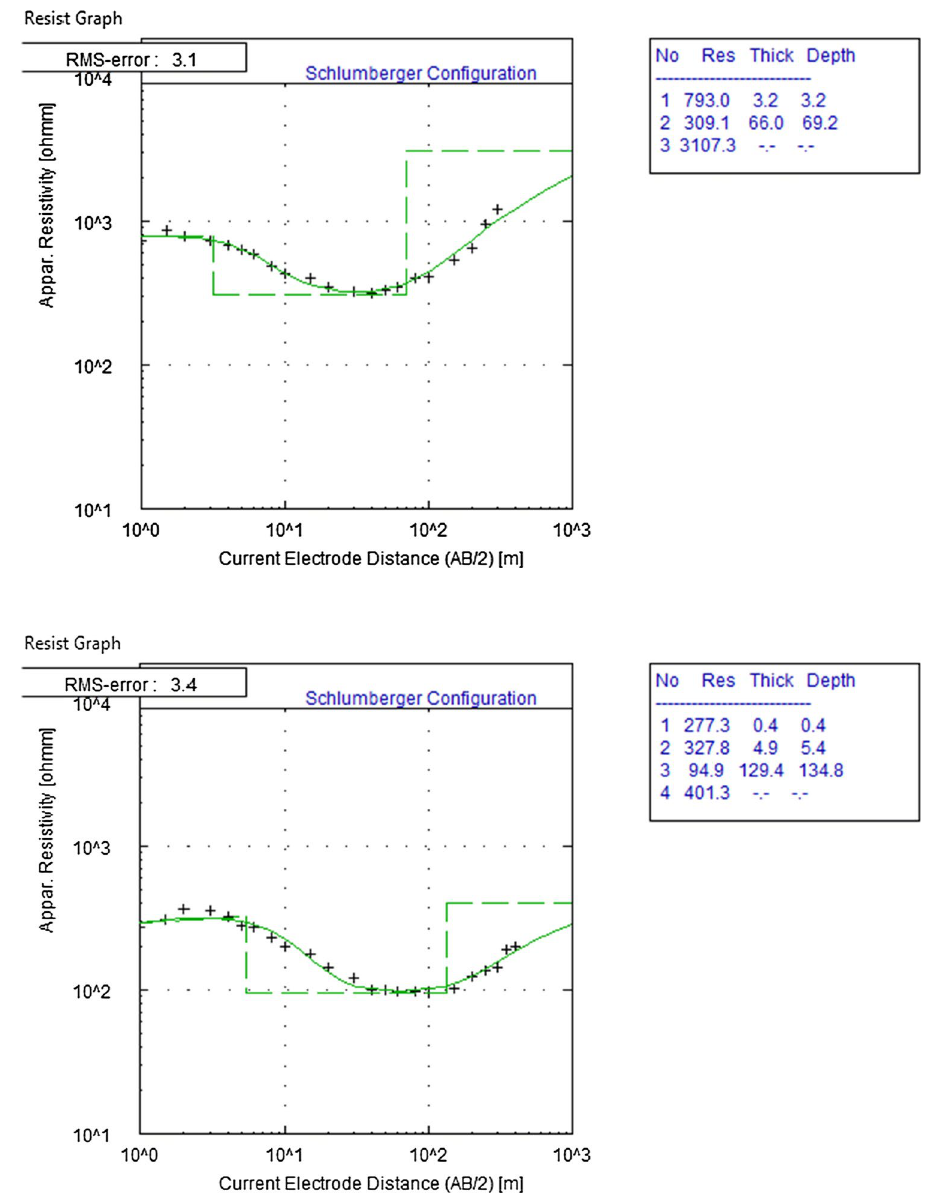
Fig. 5 Typical VES model obtained in the OM